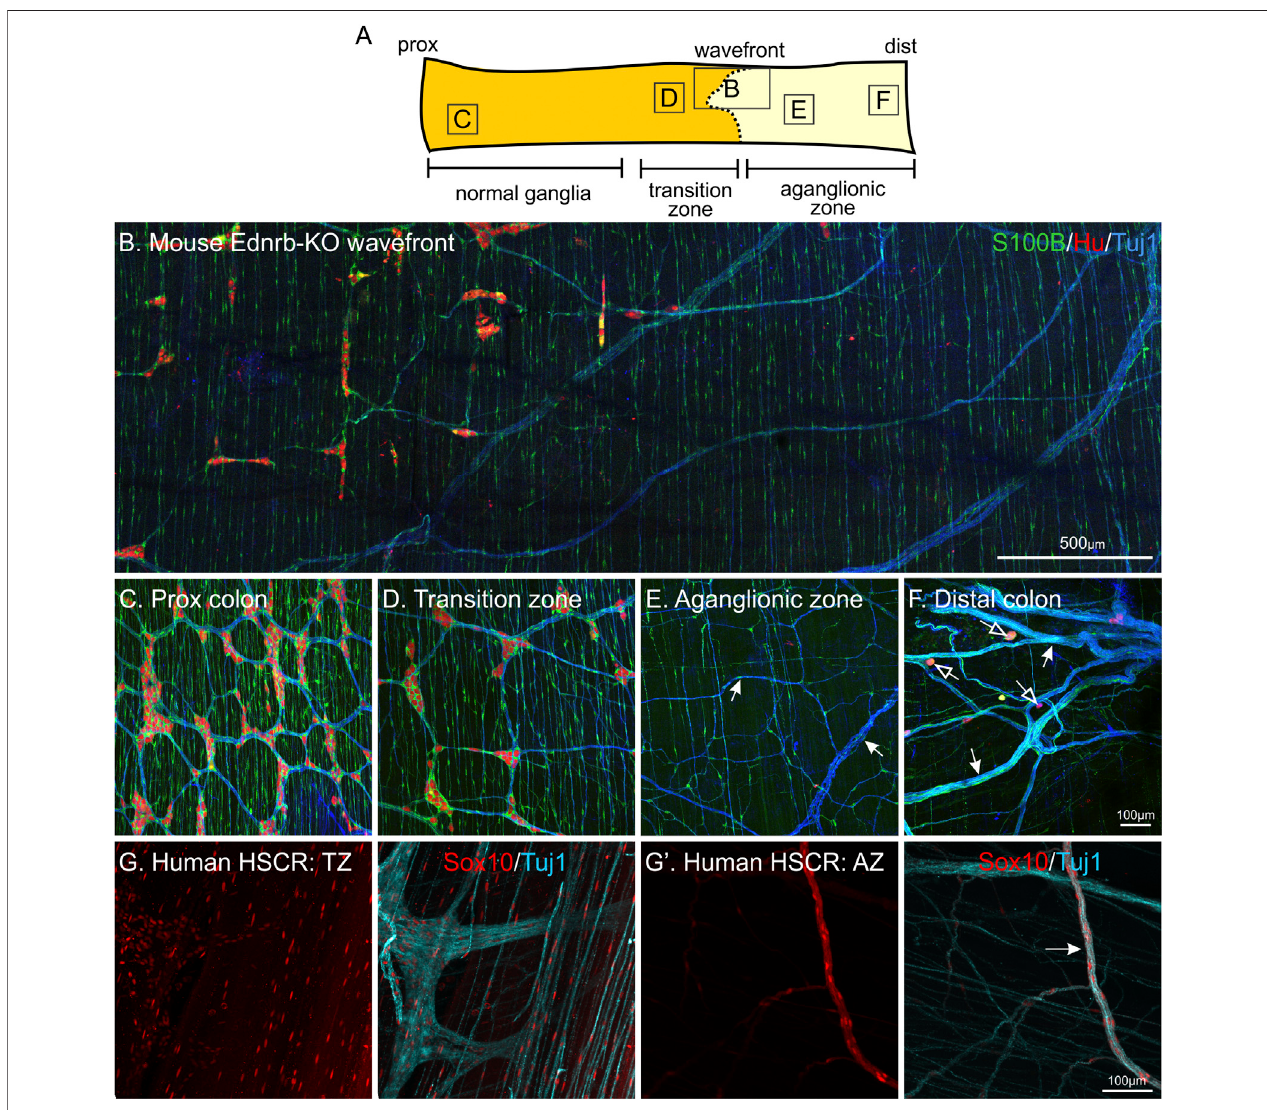
FIGURE 5 | Enteric glia are present in the gut in the absence of enteric neurons: the aganglionic zone of Hirschsprung Disease (HSCR) tissue. Whole-mount immunohistochemistry of Ednrb-KO mouse (A – F) and human HSCR patient tissue (H-H ′ ). (A) : Diagram of mouse colon including the ENS wavefront and showing the regions with “ normal ” ganglia, the transition zone (TZ), and the aganglionic zone (AZ). (B – F) : Representative images from each of these regions, following immunohistochemistryagainstS100B(green),HuC/D(red)andneuronalclassIII β − tubulin(Tuj1,blue).ThemajorityofS100B+gliaintheaganglionicregionfollow nervebundles, both large and small (arrows). Sometimes, individual Hu+neurons arepresent intheaganglionic zone(open arrows).NB. Thesearenot “ skipsegments ” astherearenoclearganglia,instead,theyarejustahandfulofindividualneuronalcellbodies. (G-G ’ ) :PatientHSCRsampleslabelledagainstSox10(red)andTuj1(blue). In the aganglionic zone, Sox10 + glia are also associated with nerve processes. The same proximal — distal orientation has been maintained in all tissues.